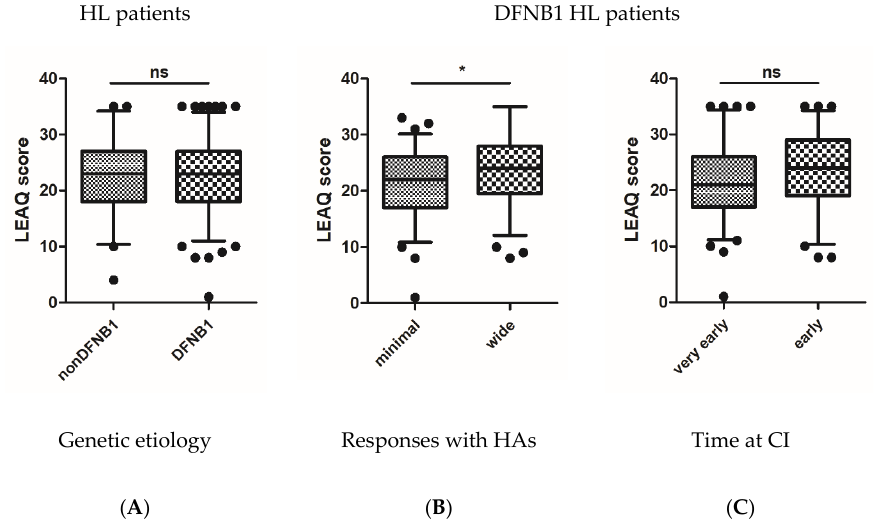
Figure 3. LEAQ scores in the fifth month after cochlear implantation. ( A ) Differences in LEAQ scores in patients with and without DFNB1 locus pathogenic variants; ( B ) differences in LEAQ scores in patients with minimal and wide responses provided by HAs; ( C ) differences in LEAQ scores in patients with very early and early CI. Whiskers represent 5–95 percentile and black dots indicate outliers. Asterisks represent statistical significance, * p < 0.05; ns, not significant. J. Clin. Med. 2020 , 9 , x FOR PEER REVIEW